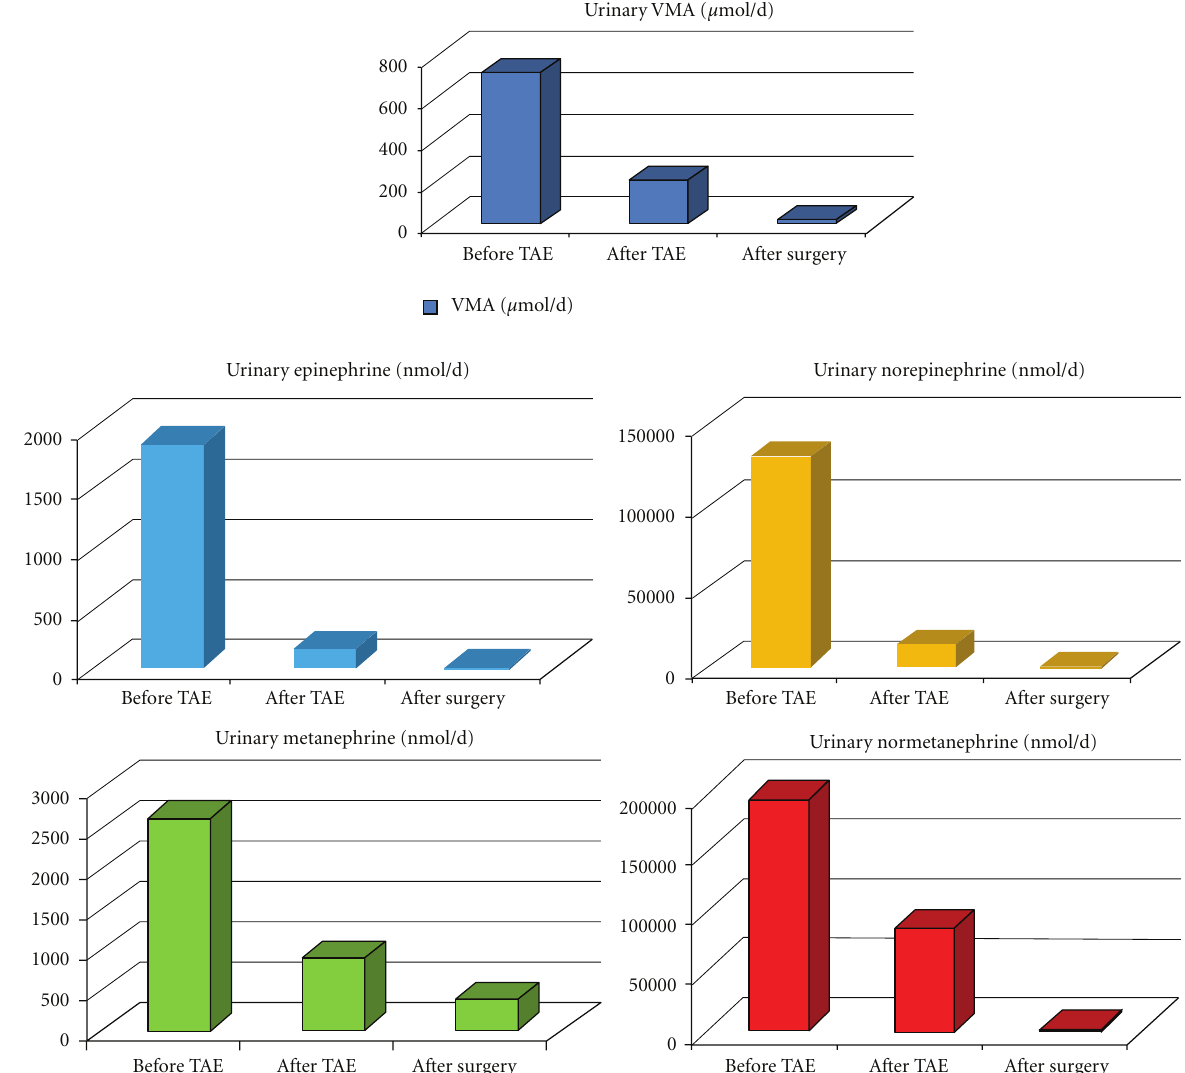
Figure 6: Changes in 24h urinary VMA, free CATH (E+NE), and Metanephrines (METH+NMETH) following TAE and surgery.